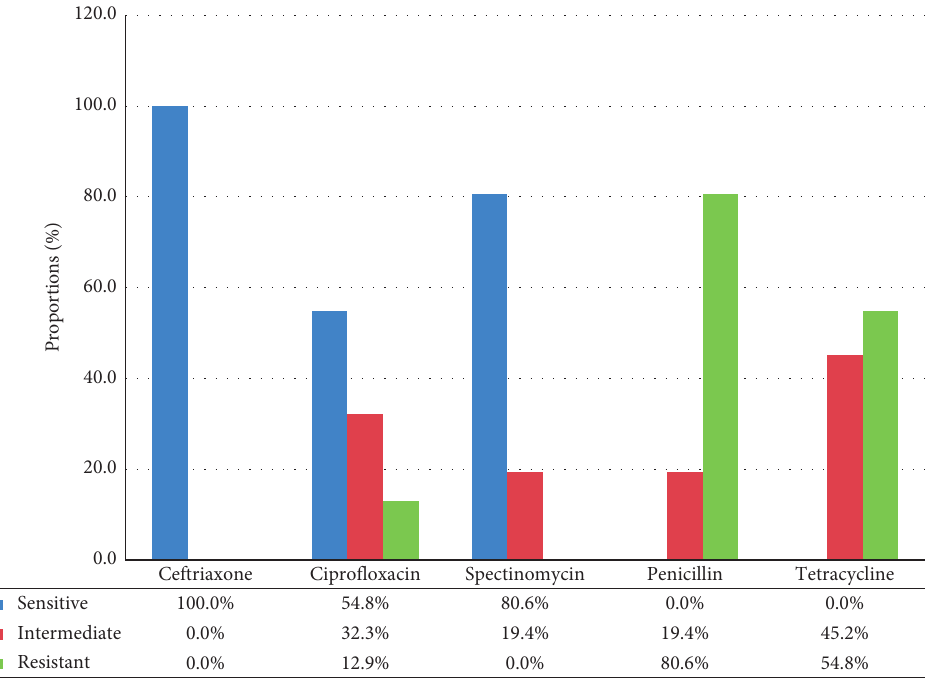
Figure 1: Antimicrobial susceptibility patterns of N. gonorrhoeae isolated from patients suspected of gonococcal